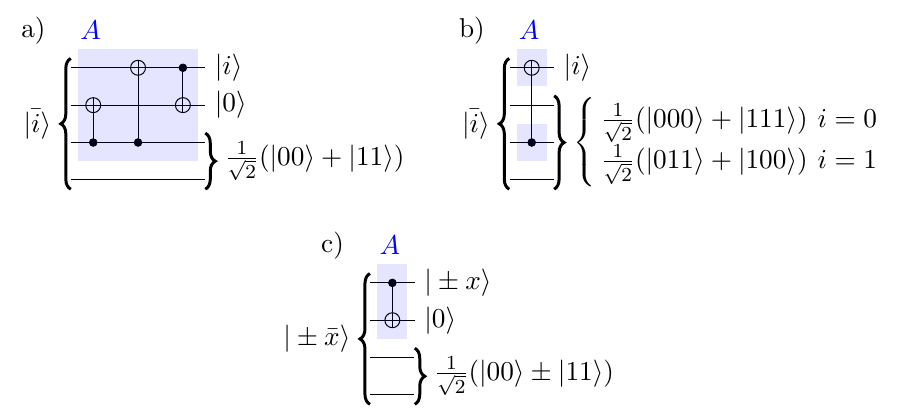
Figure 7. The decoding operations in the Z 1 Z 2 = +1 gauge for (a) a 3-1 bipartition (3.16), (b) one 2-2 bipartition (3.21), (3.22), and (c) the other 2-2 bipartition